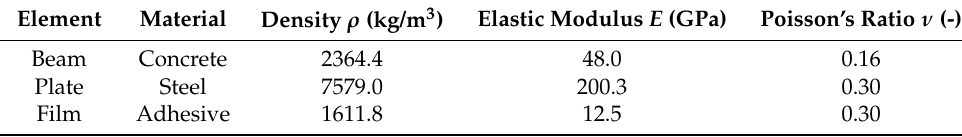
Table 1. Material parameters of the consisting elements of the composite